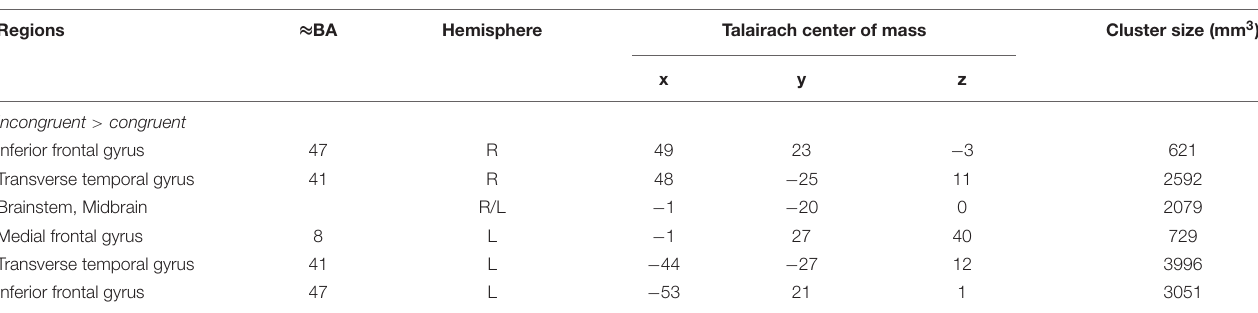
FIGURE 1 | Depicted are sagittal views on the left (L) and right hemisphere and the horizontal view on the averaged brain of the measured population at Talairach coordinates X = 46, –46 and Z = –2. Color coded are voxels that survived conservative significance level of p < 0.05 corrected for multiple comparisons (Bonferroni, Bonf) for the main factor AV congruency. The use of this very conservative significance level was necessary for isolation of separated clusters due to the fact of widespread activation clusters covering almost the whole brain resulting from strong congruency effect and spatial smoothing at the same significance level but corrected for multiple comparisons by means of the false discovery rate. TABLE 2 | Significant brain clusters identified for the main factor AV